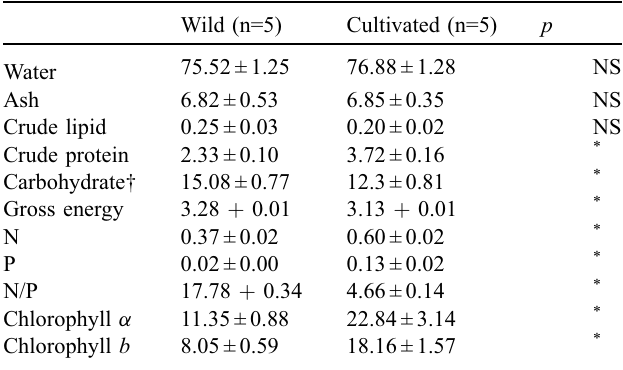
Table 7. Proximate composition (% w.w.), gross energy (kJg (cid:1) 1 ), N, P (% w.w.), N/P and chlorophyll ( m g g (cid:1) 1 ) of wild and bi-weekly cultivated Ulva.